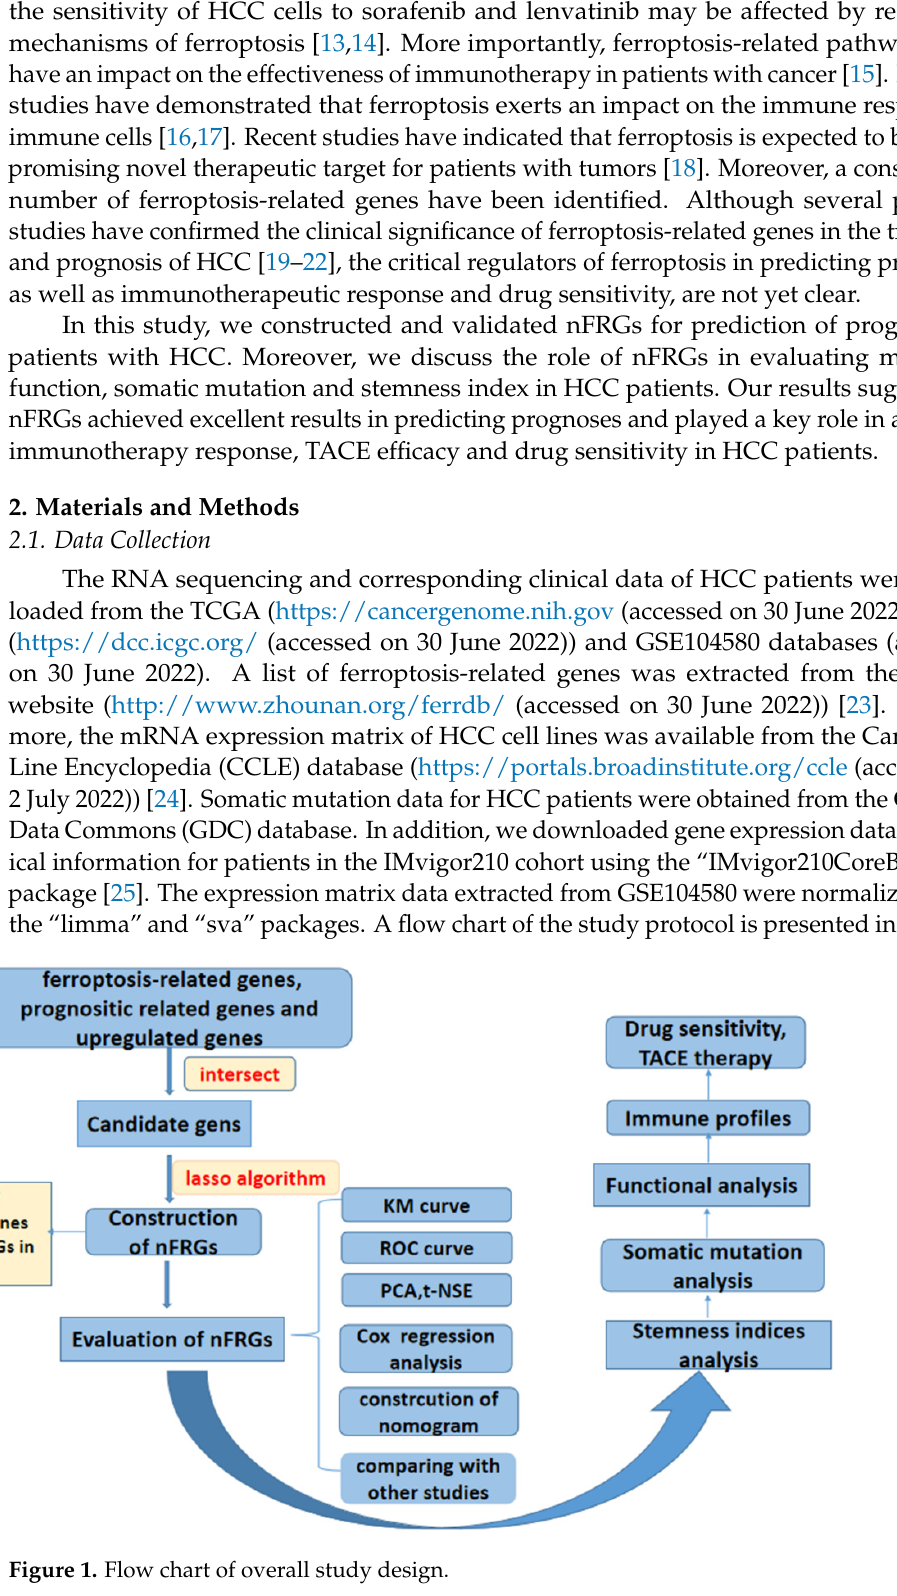
Figure 1. Flow chart of overall study design.